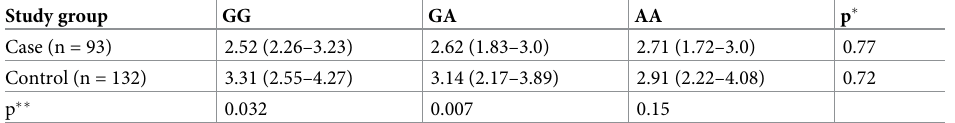
Table 5. Statistical association between serum BDNF levels and BDNF rs11030094 genotypes in the case and con- trol